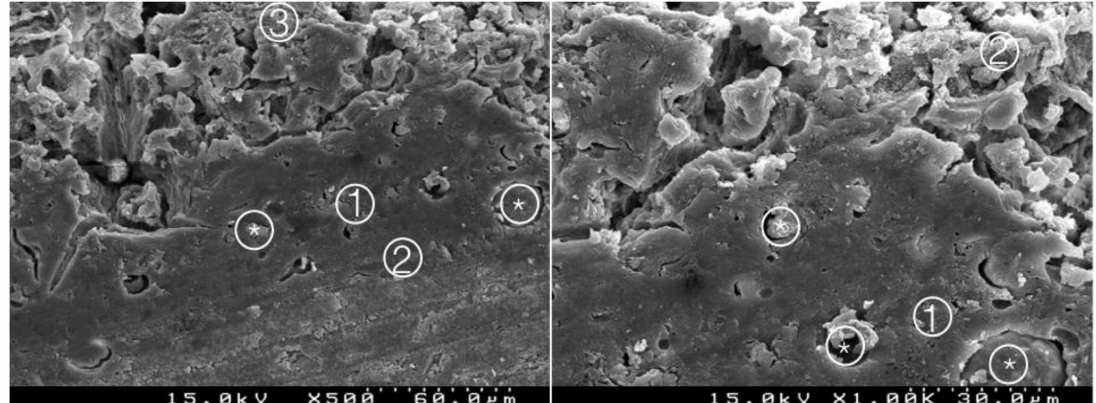
Figure 5. Group 3 (BiodentineSE1I): considerable interdigitation between the adhesive system and CSC. A thick hybrid layer is presented 1 (cid:13) . Particles of cement involved by the adhesive (*). Adhesive 2 (cid:13) and Biodentine TM 3 (cid:13) (original magnification 500 × and 1000 × ).